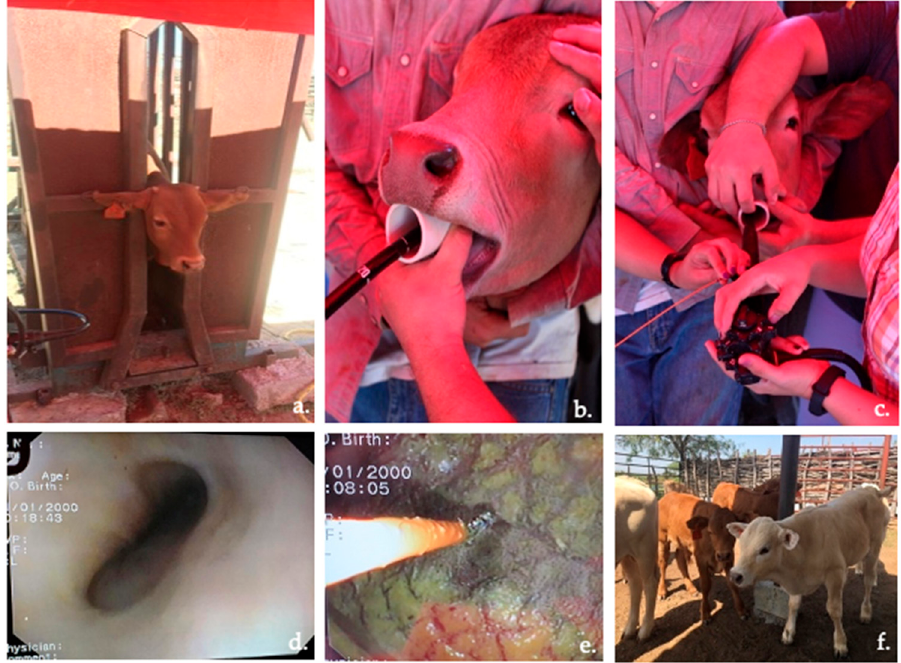
Figure 3. Rumen oral endoscopic biopsy process: ( a ) calf immobilization; ( b ) endoscope insertion through oral cavity; ( c ) focusing the endoscope; ( d ) esophagus visualization; ( e ) obtaining a rumen epithelial sample from the cranial–dorsal sac using the forceps; and ( f ) calf